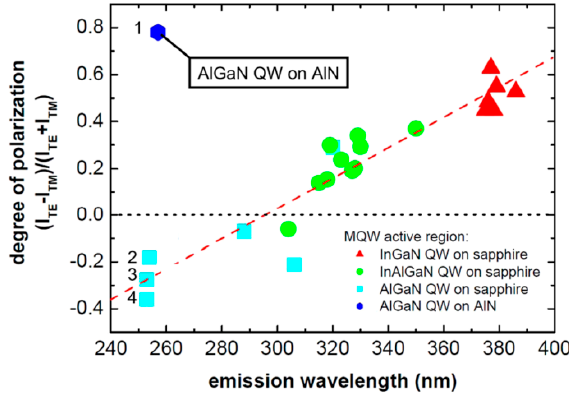
Figure 8. Degree of polarization of emission from LEDs fabricated on sapphire or AlN substrates. For the devices grown on sapphire, TE polarization is obtained at wavelengths greater than ~310 nm and TM polarization is obtained for wavelengths less than ~310 nm. Device 1, in the upper left hand corner represents a different approach in that its active region consisting of short period AlGaN/AlGaN quantum wells was pseudomorphically grown on AlN. As depicted, it emits highly TE polarized light at 253 nm. The quantum wells in Devices 2–4 (cyan colored squares) are identical in design to Device 1 but are grown on sapphire. The long dashed line is intended to illustrate the trend for LEDs grown on sapphire while the horizontal dotted line depicts the case of equally split polarization. Reprinted from [92], with the permission of AIP publishing.